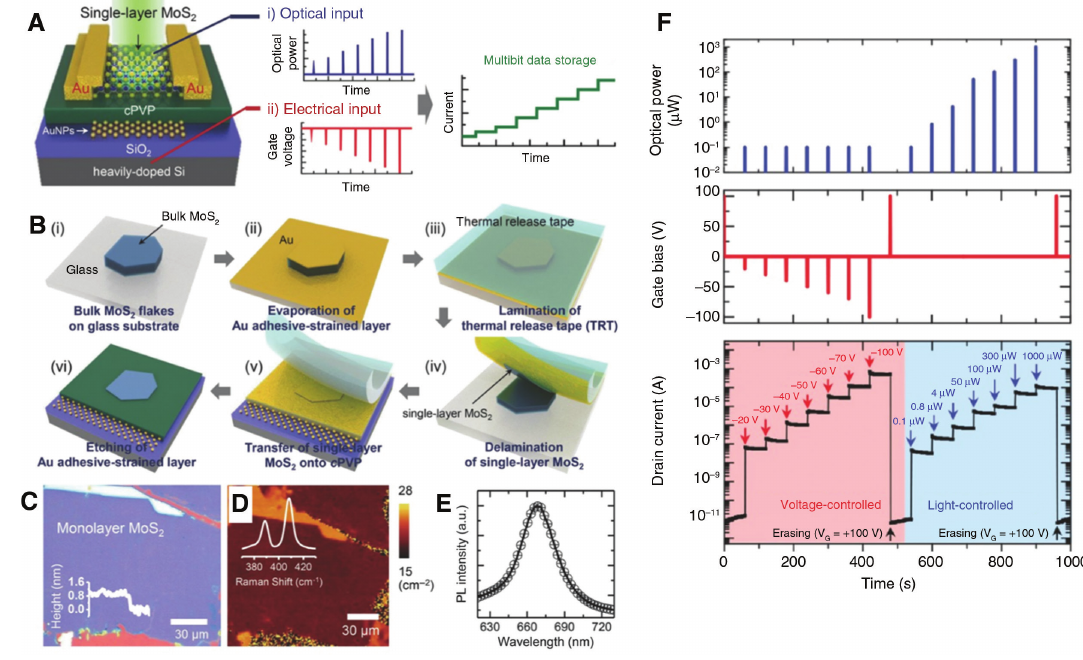
Figure 10: Optoelectronic memory with monolayer MoS